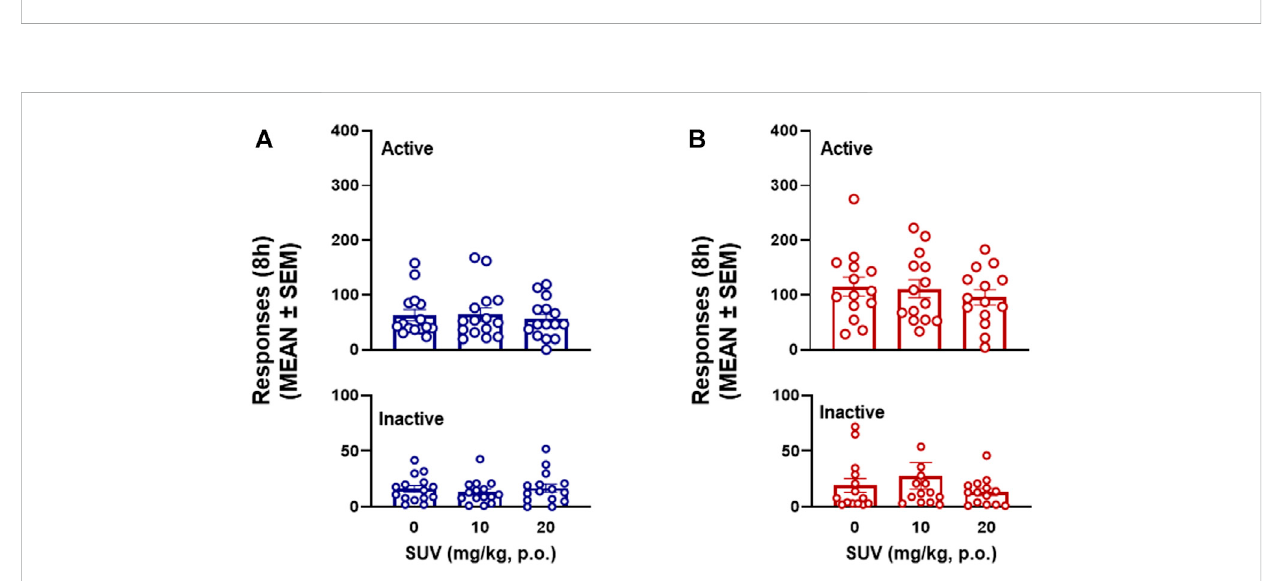
FIGURE 3 Effect of suvorexant on 8-h oxycodone self-administration in males ( n = 15) (A) and females ( n = 14) (B) .